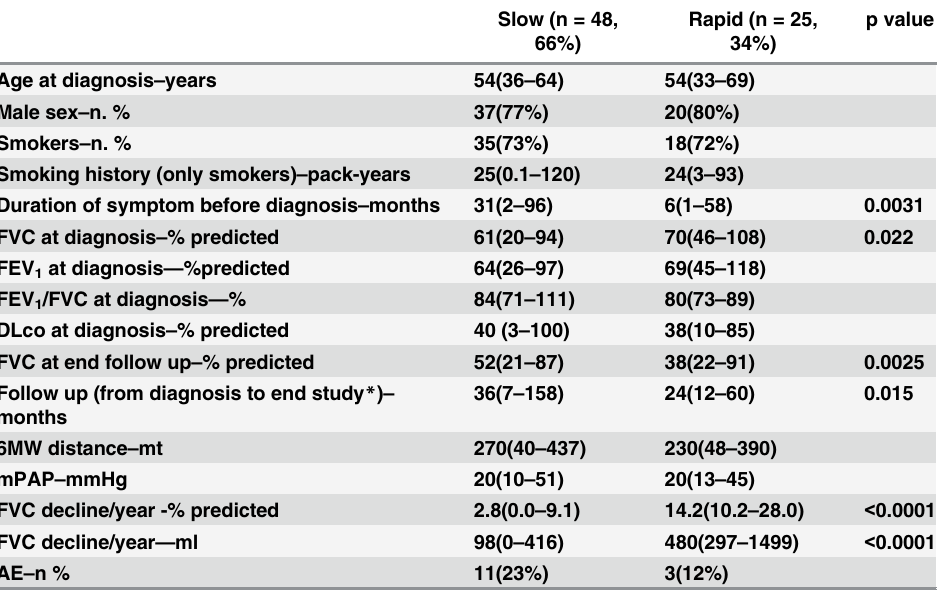
Table 1. Clinical characteristics of slow and rapid